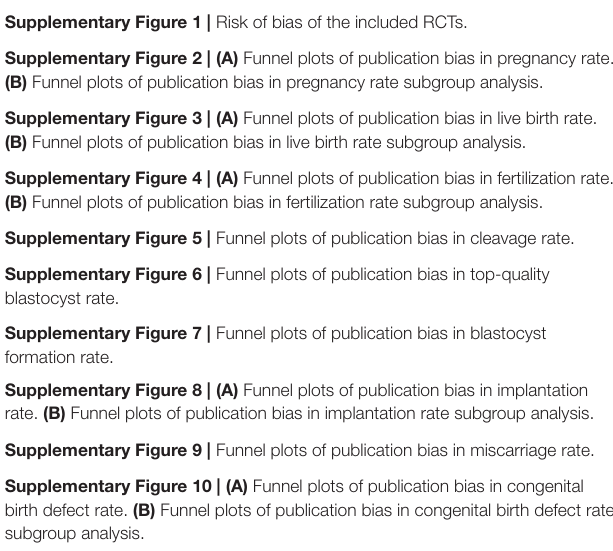
Supplementary Figure 2 | (A) Funnel plots of publication bias in pregnancy rate. (B) Funnel plots of publication bias in pregnancy rate subgroup analysis. Supplementary Figure 3 | (A) Funnel plots of publication bias in live birth rate. (B) Funnel plots of publication bias in live birth rate subgroup analysis. Supplementary Figure 4 | (A) Funnel plots of publication bias in fertilization rate. (B) Funnel plots of publication bias in fertilization rate subgroup analysis. Supplementary Figure 5 | Funnel plots of publication bias in cleavage rate. Supplementary Figure 6 | Funnel plots of publication bias in top-quality blastocyst rate. Supplementary Figure 7 | Funnel plots of publication bias in blastocyst formation rate. Supplementary Figure 8 | (A) Funnel plots of publication bias in implantation rate. (B) Funnel plots of publication bias in implantation rate subgroup analysis. Supplementary Figure 9 | Funnel plots of publication bias in miscarriage rate. Supplementary Figure 10 | (A) Funnel plots of publication bias in congenital birth defect rate. (B) Funnel plots of publication bias in congenital birth defect rate subgroup analysis. Supplementary Figure 11 | Funnel plots of publication bias in sex